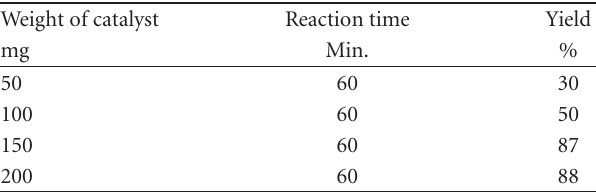
Table 1: E ff ect of weight of H-MCM-22 on the synthesis of 1,5-